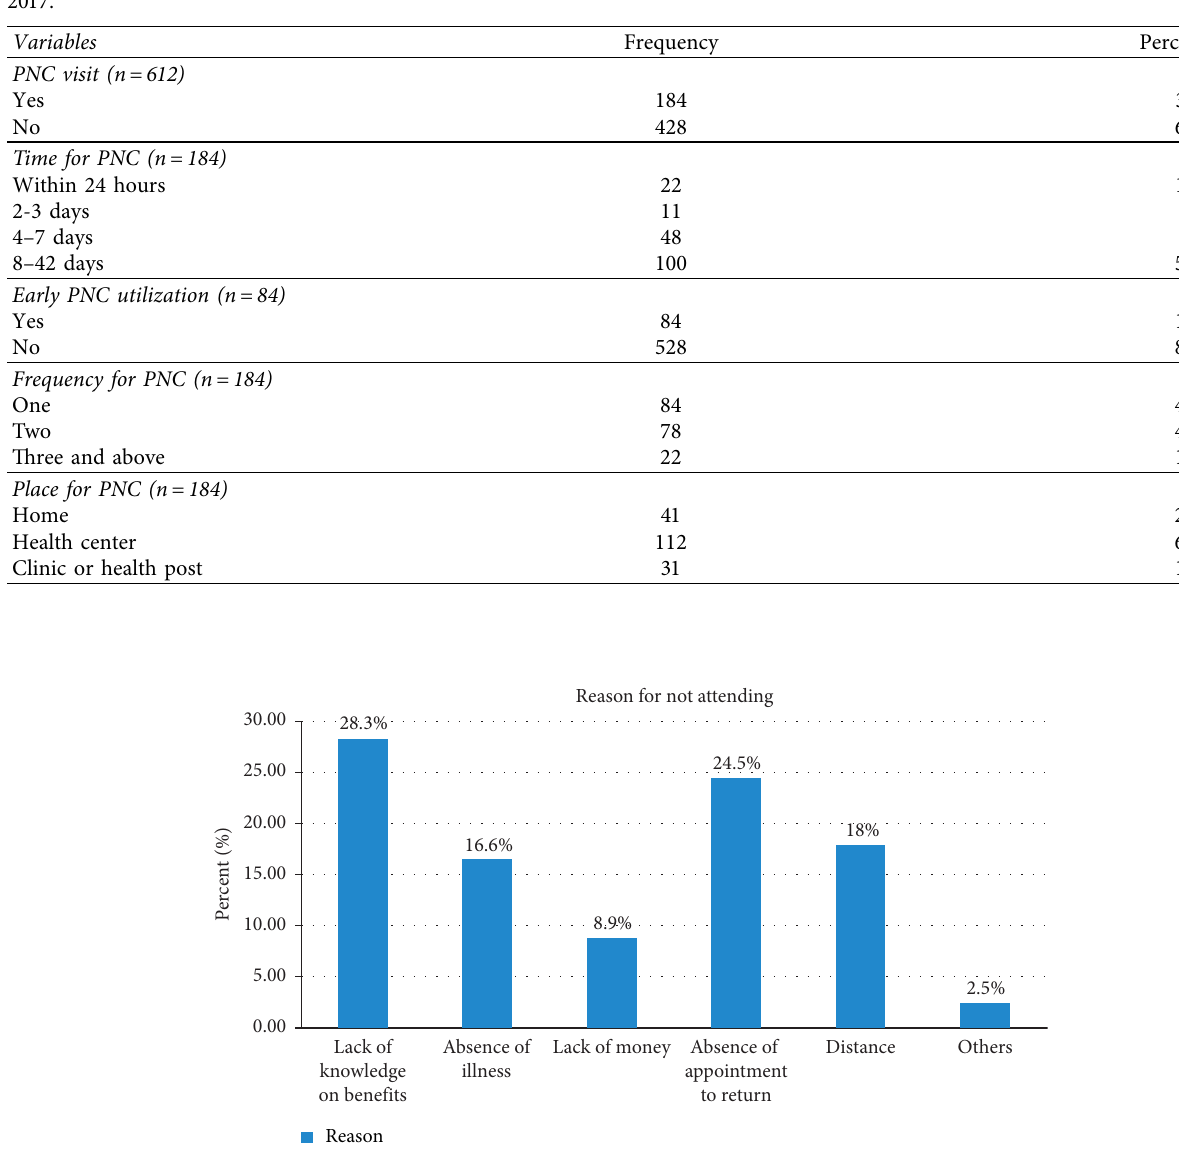
Figure 2: Respondents’ reasons for not attending early postnatal care service among mothers who gave birth in the last six months at Wonago District, South Ethiopia,